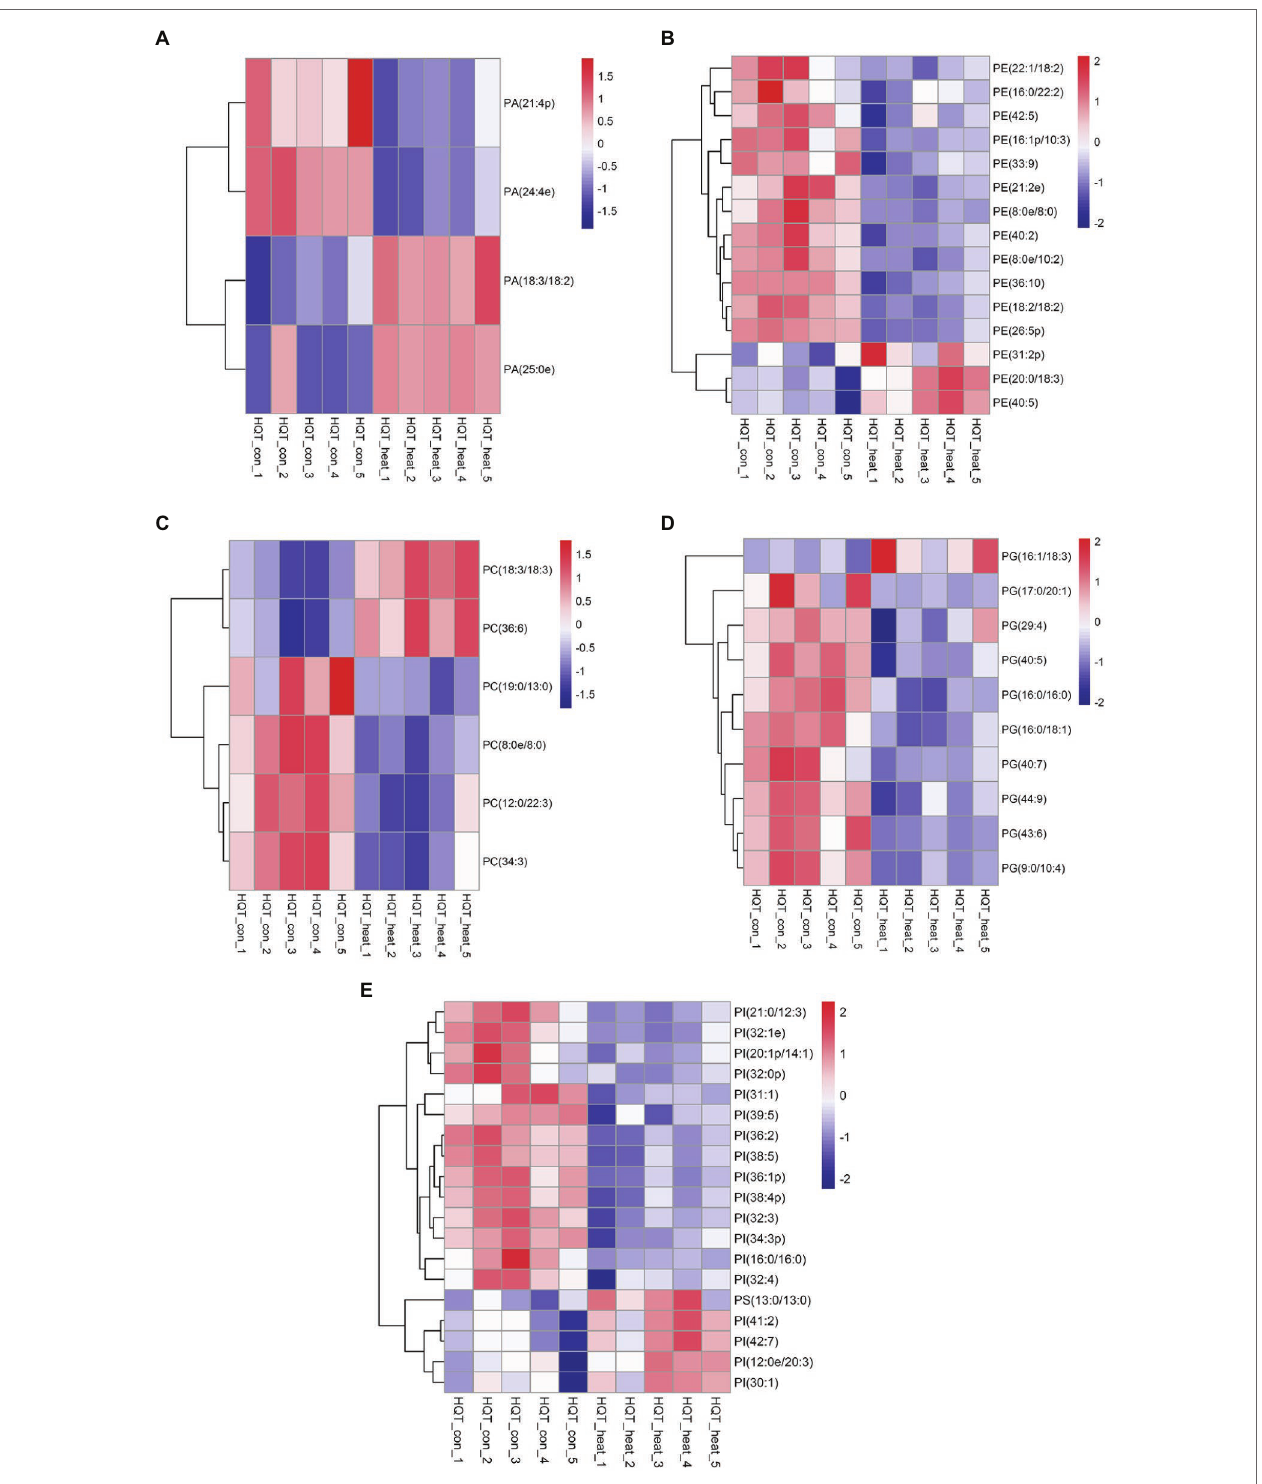
FIGURE 5 | Heat map of profiles for the phospholipid species identified in leaves of B. grandis under heat stress. Each column represents an LC–MS measurement from five biological replicates of control condition (HQT_con_1 to HQT_con_5) or five biological replicates of heat treatment (HQT_heat_1 to HQT_heat_5). Fully extended leaves detached from 173-d-old plants of B. grandis were at control condition (22 ° C for 2 h) or challenged with heat stress (45 ° C for 2 h). The phospholipid species of (A) PA, phosphatidic acid, (B) PC, phosphatidylcholine, (C) PE, phosphatidylethanolamine, (D) PG, phosphatidylglycerol, (E) PI, phosphatidylinositol and PS, phosphatidylserine, measured from the control and heat treatment conditions were